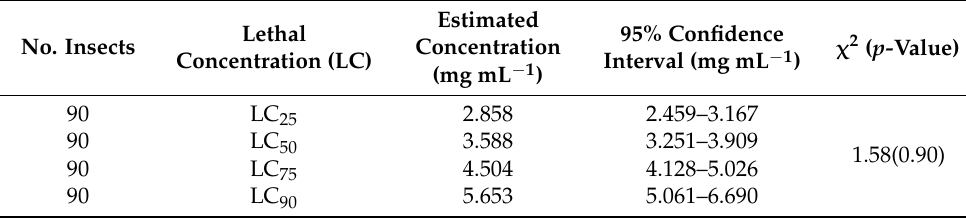
Table 1. Lethal concentration of deltamethrin against Spodoptera frugiperda caterpillars after 5 days exposure, obtained from Probit analysis (df = 5, slope ± SE = 6.364 ± 0.53, intercept = 3.519).